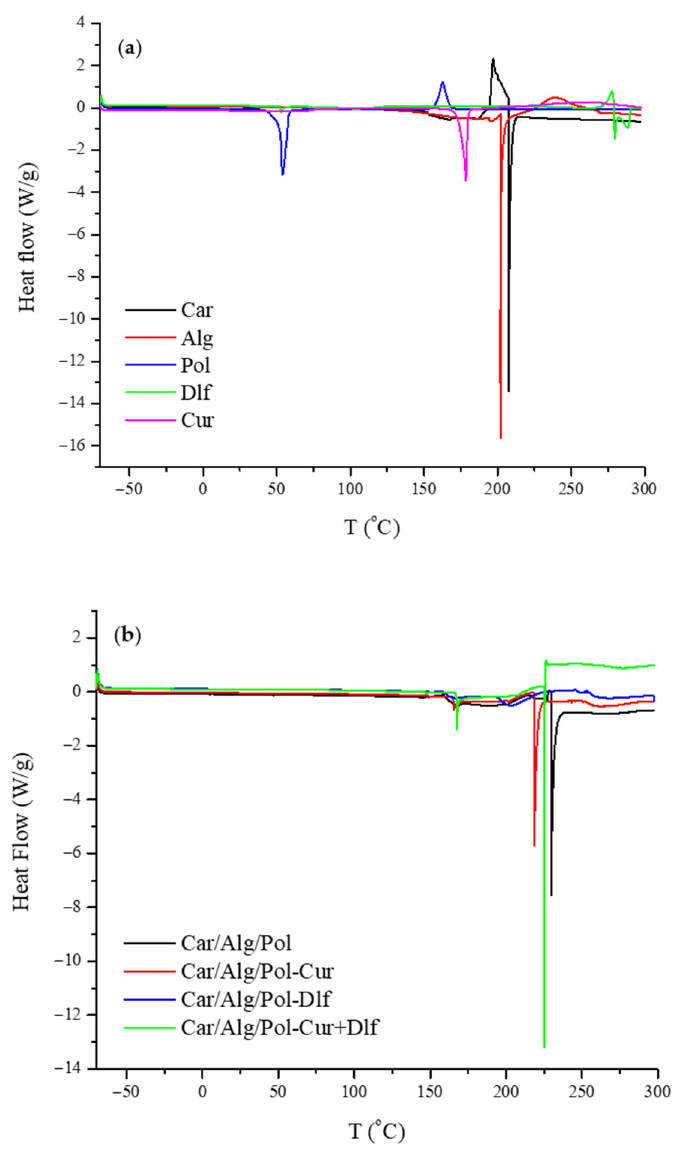
Figure 5. DSC thermograms of ( a ) starting components and ( b ) prepared films.